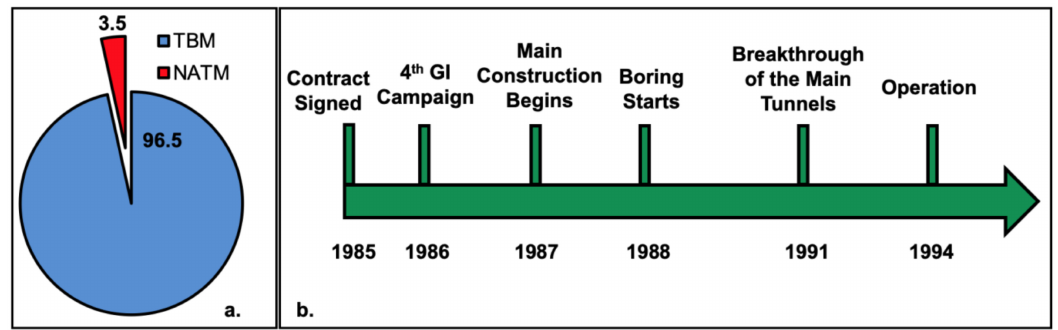
Figure 7. ( a ) Method used for the excavation. ( b ) Timeline of Channel tunnel between